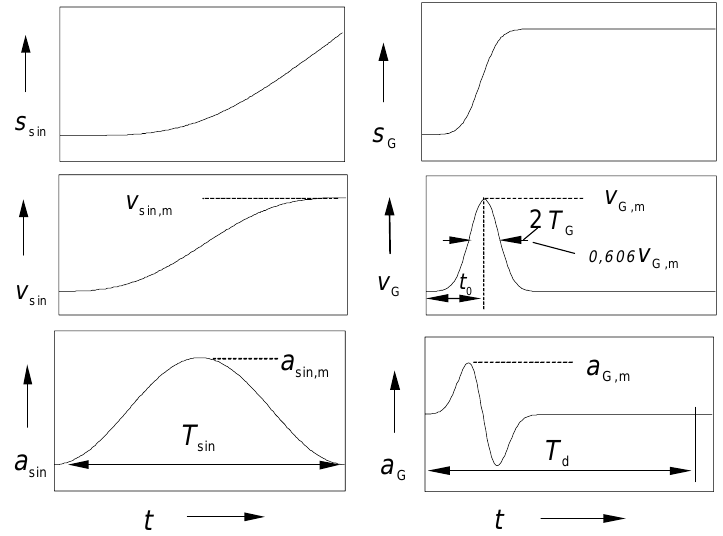
Fig. 2. Displacement s ( t ) , velocity v ( t ) and acceleration a ( t ) curves. (Left) Sine squared impulse and (right) Gaussian